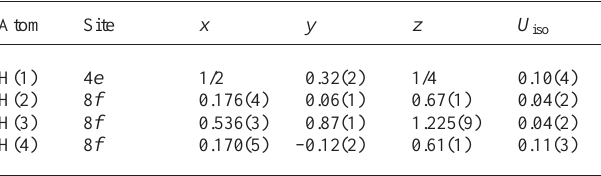
Table 2. Atomic coordinates and displacement parameters (in Å 2 )